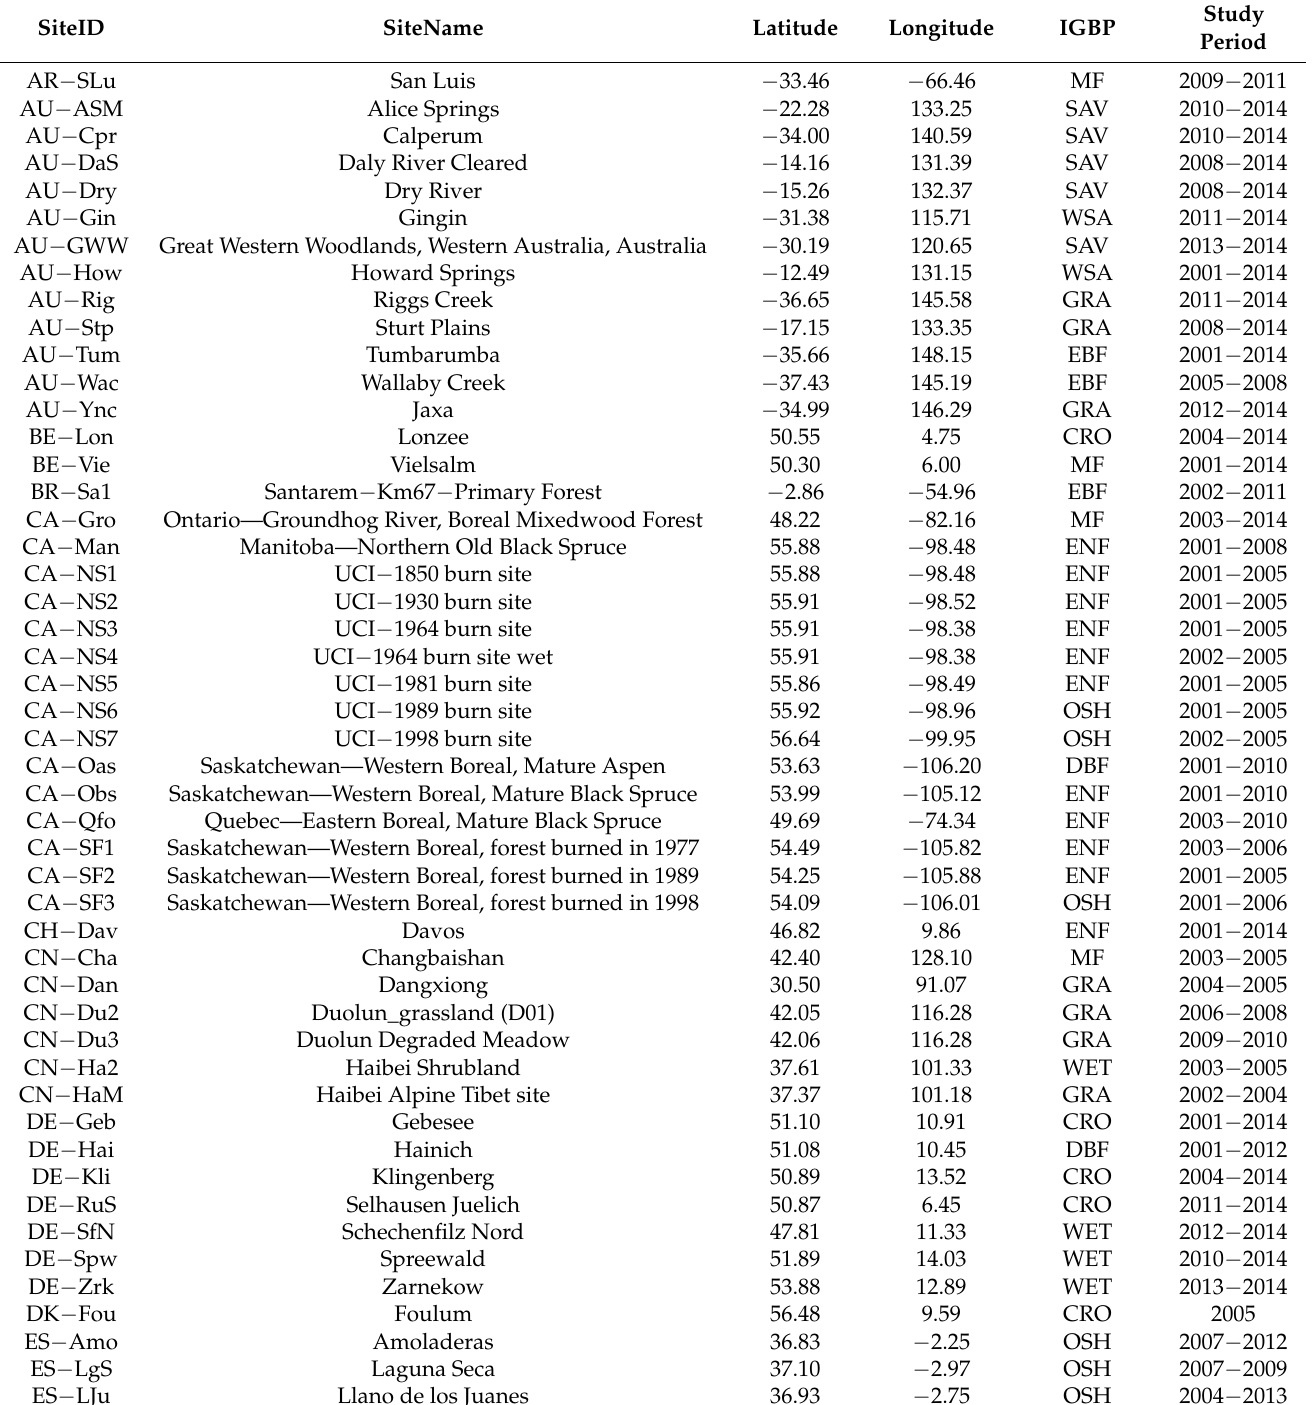
Table A4. FLUXNET sites used in this